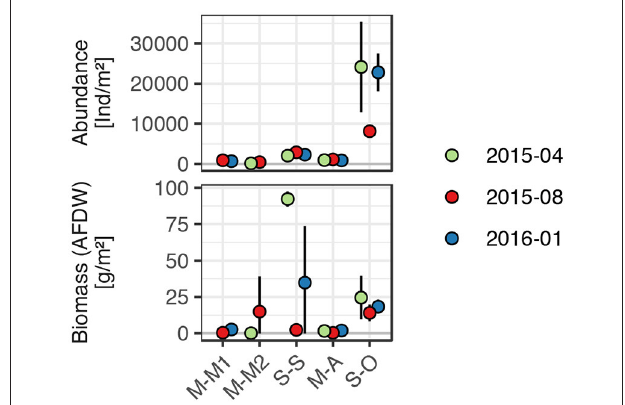
FIGURE 4 | Total macrozoobenthos abundance and biomass (ash free dry weight) in the incubated short cores. Points and errorbars represent means ± one standard deviation of 2 to 4